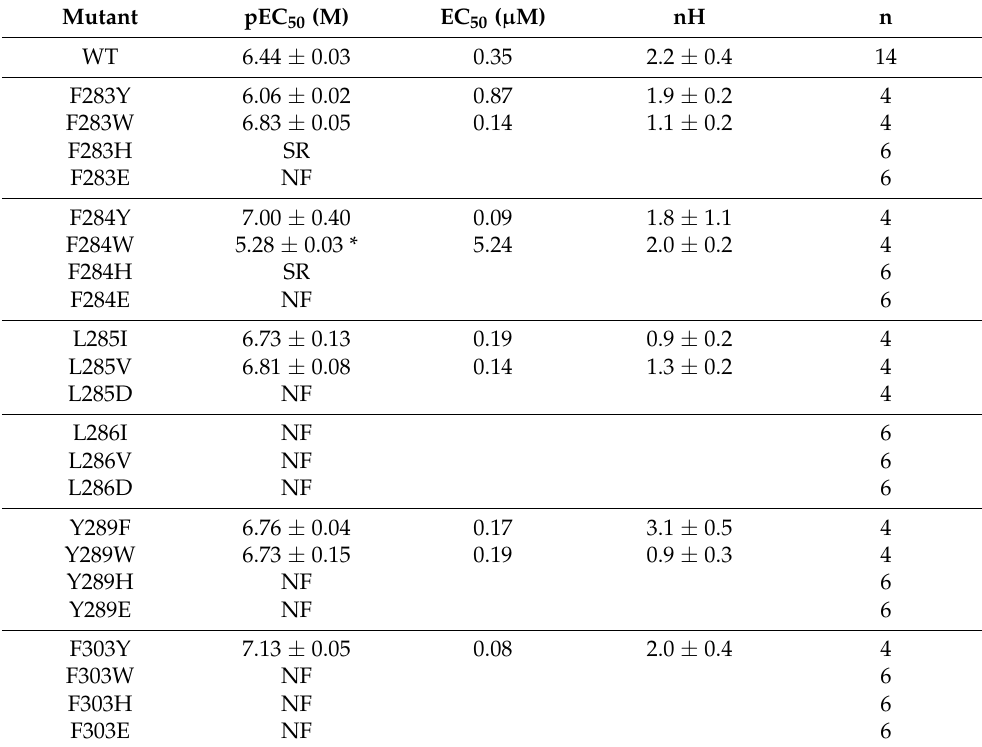
Table 2. Parameters derived from concentration–response curves after substitution of a selection of M1 helix